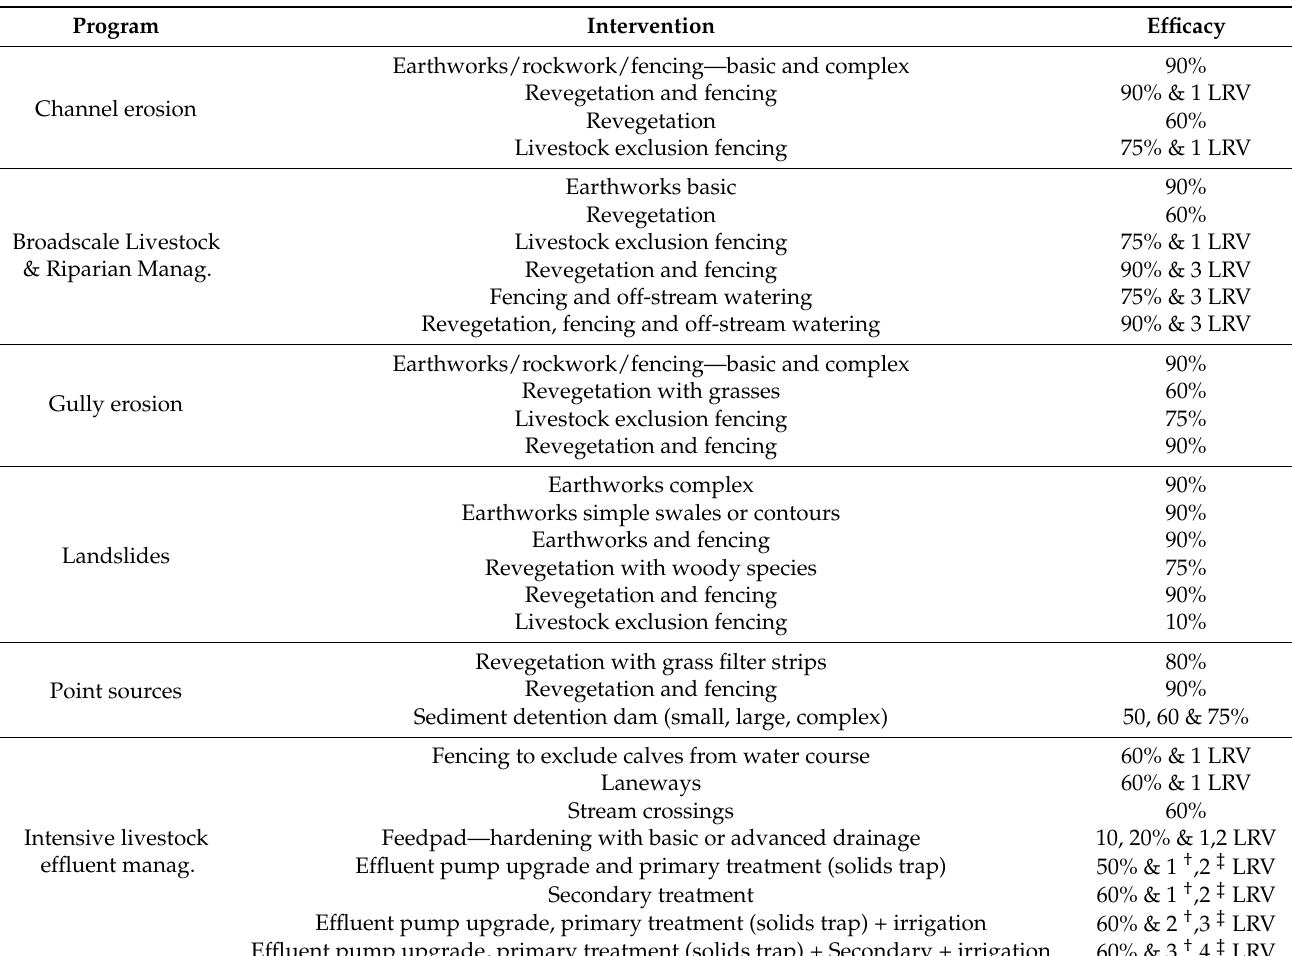
Table 3. Intervention programs and available intervention types to mitigate source catchment water quality risks in the Logan-Albert catchment case